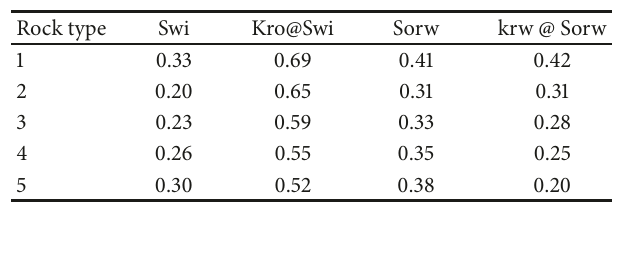
Table 2: Endpoint values of relative permeability curve of each rock type.